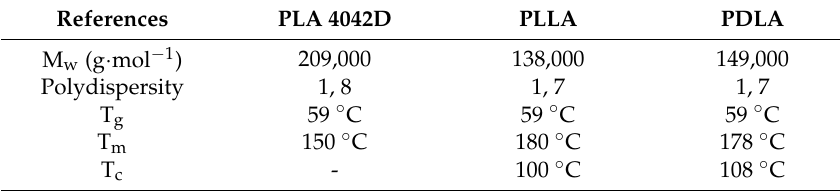
Table 1. Polymers physical